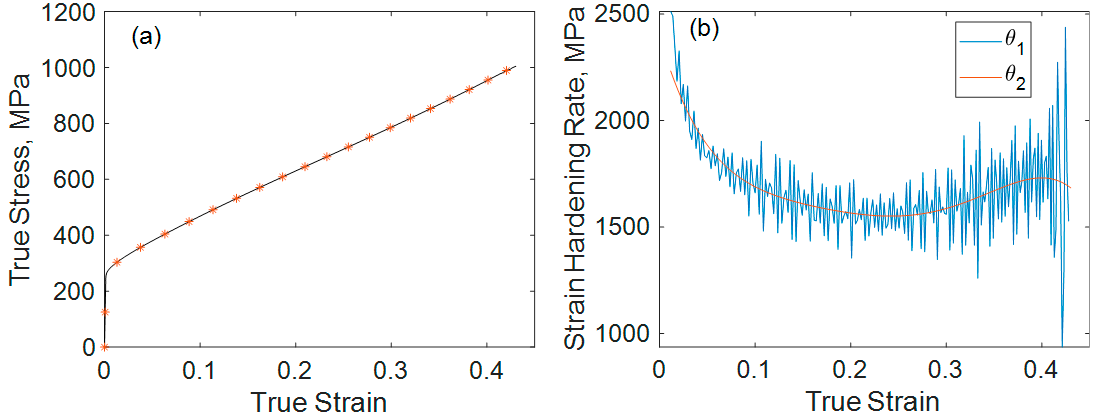
Figure 3. ( a ) True stress–true strain curve and centers for the analyzed intervals and ( b ) strain hardening rates shown as a function of true strain. θ 1 and θ 2 were defined as Δσ / ΔΕ in 100 s, and the differential curve for σ ( Ε ) was fitted using a 6th-order polynomial function, respectively.